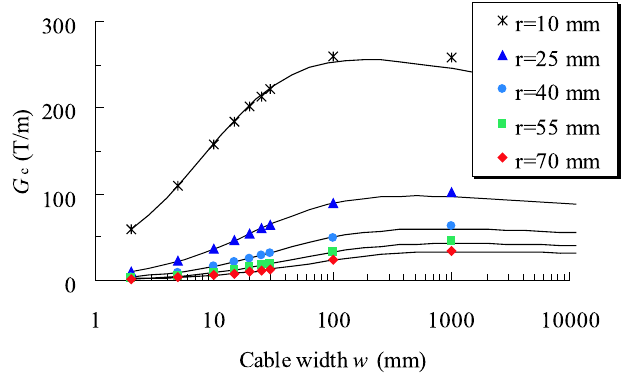
FIG. 6. (Color) Critical gradient versus cable width for different apertures: numerical results (dots) and analytical approximation (solid lines) for the cross-quadrupole model, for (cid:3) (cid:2) 0 : 33